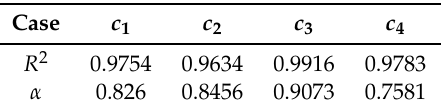
Table 1. MSD of average HA chain for normal case fit parameters. Symbols: c 1 = 0 (indicating pure